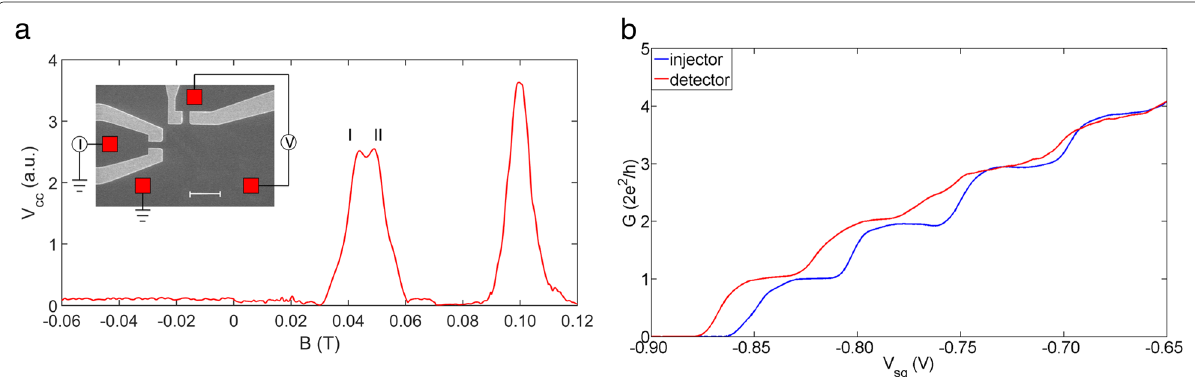
Fig. 1 The experiment setup and device characteristic. a A representative plot of transverse electron focusing with both the injector and detector set to G 0 (2e 2 /h). V cc is the voltage drop across the detector. Focusing peaks are well defined with a positive magnetic field, and the signal is negligible with a negative magnetic field. The first peak shows pronounced splitting. The two sub-peaks have been highlighted as peak I and peak II. The inset shows an SEM image of the device. The separation between the injector and detector is 1.5 μ m. Red squares form the Ohmic contacts whereas two pairs of grey-coloured gates, left and top, form the injector and detector, respectively. The scale bar is 2 μ m. b Conductance characteristics of the injector and